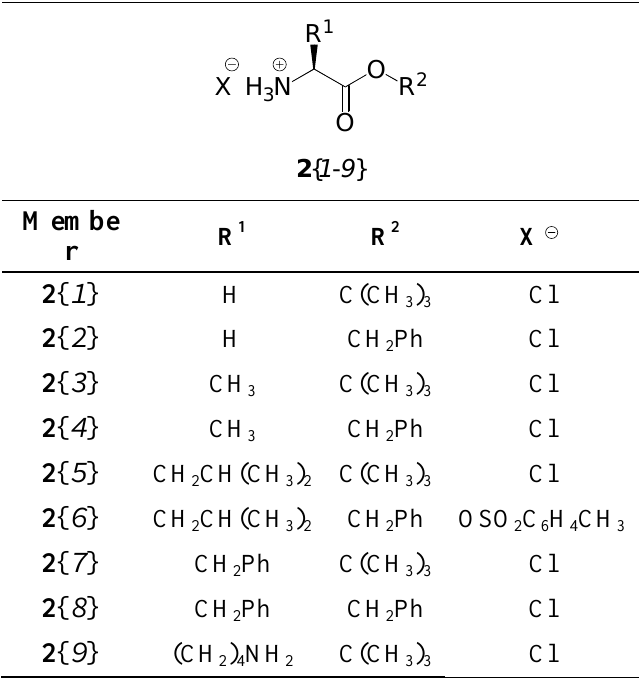
Table 1 . Amino acid ester salts, 2 { 1 - 9 }, used in library